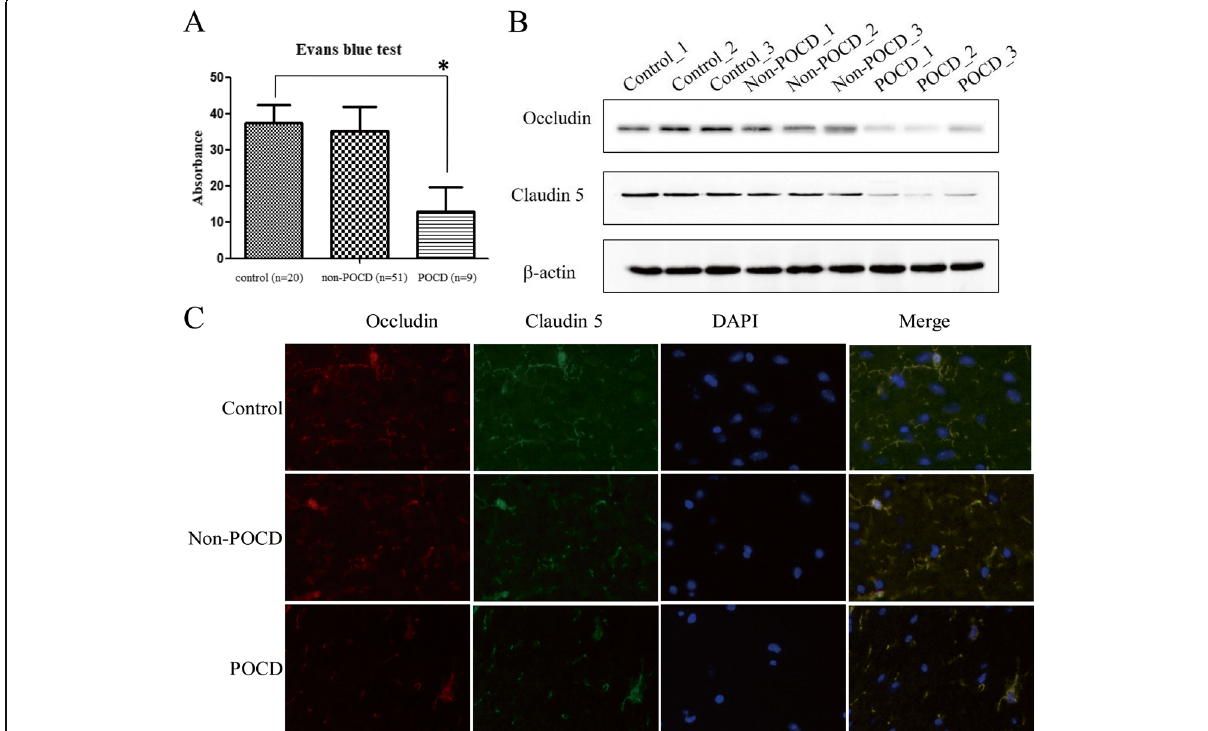
Fig. 2 BBB situation of POCD. The absorbance of evans blue ( a ) and Occludin and Claudin 5 expression in hippocampus by WB ( b ) and IF assay ( c ) in POCD. “ * ” represents statistical